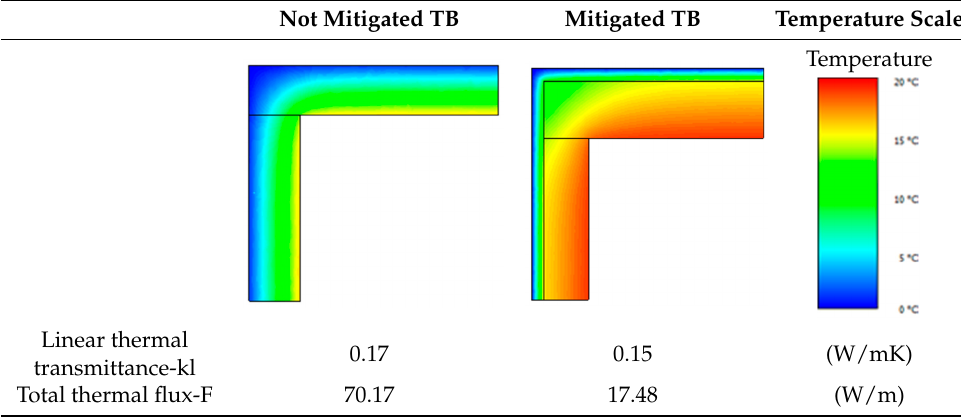
Table 11. R Thermal bridges.